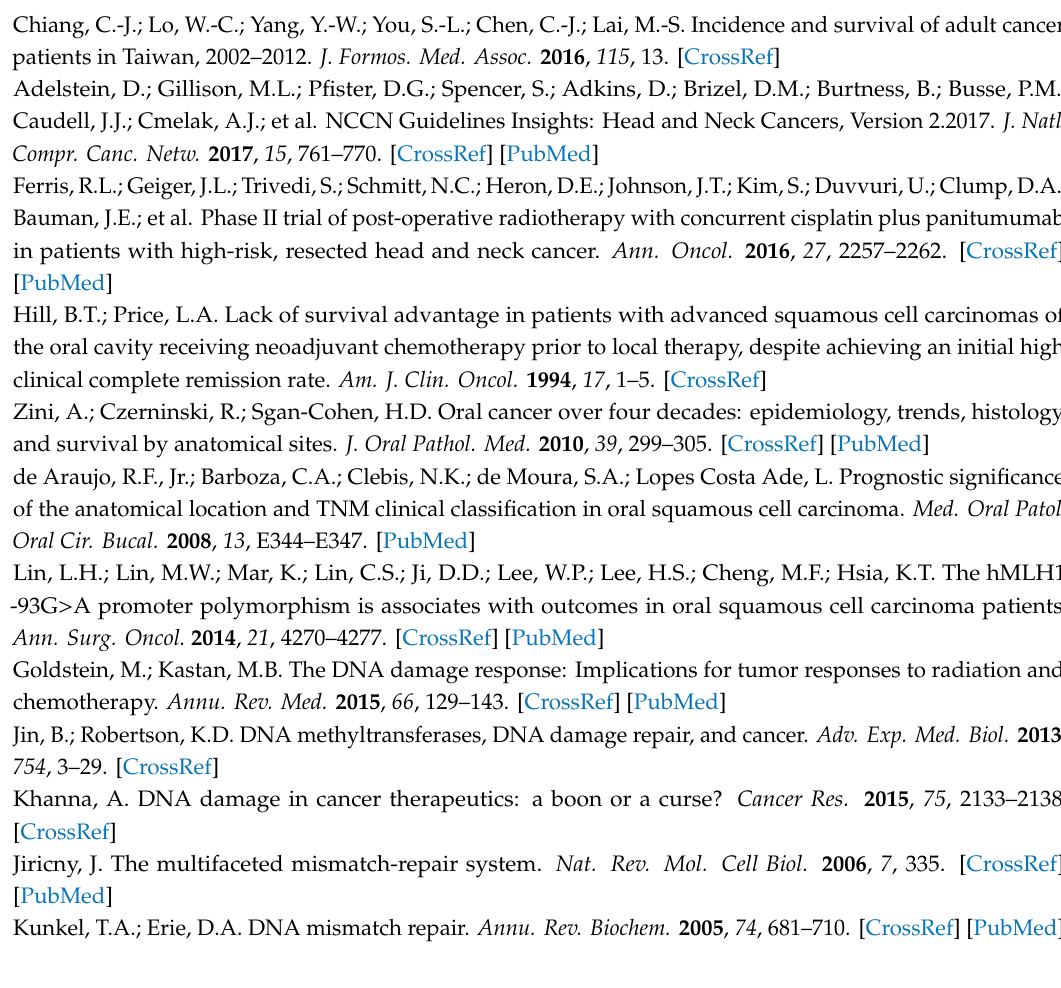
Figure S1: Linkage disequilibrium analysis between SNPs in MSH3 (rs12515548 and